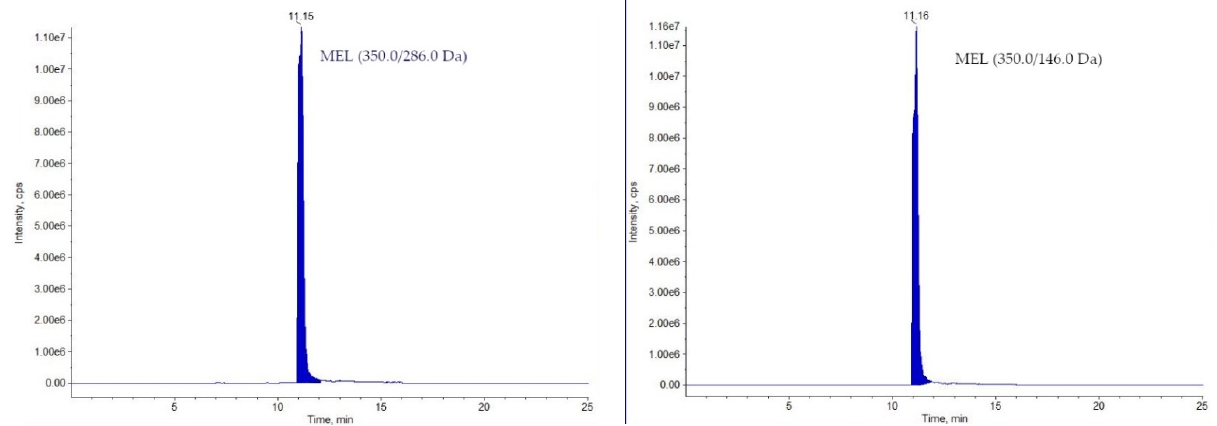
Figure 2. Chromatograms of the non-compliant sample of milk containing DC.